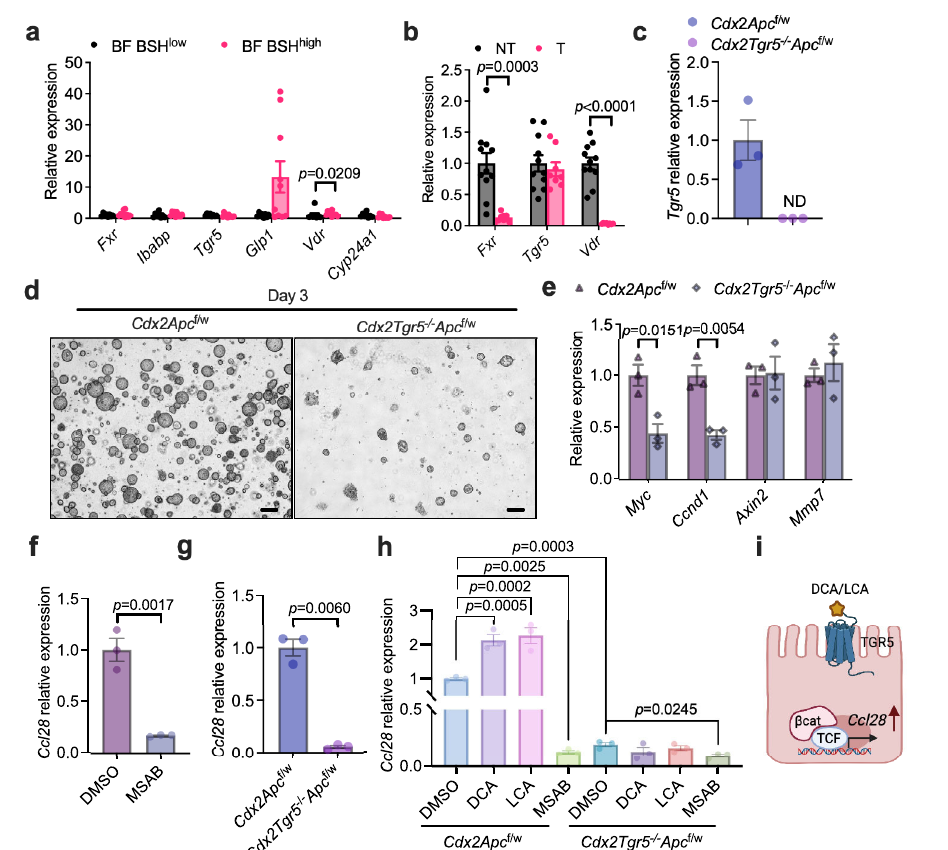
Fig. 8 | DCA/LCA activates TGR5 signaling that regulates Ccl28 expression in the presence of β -catenin. a HFD-fed Cdx 2 Apc f/w mice were colonized with